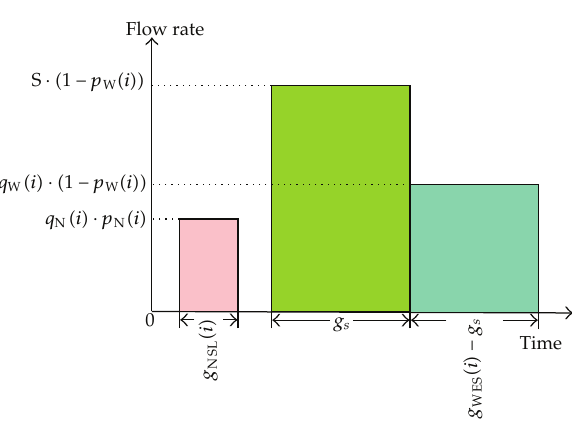
Figure 2: Pulse arrival flows schema of downstream